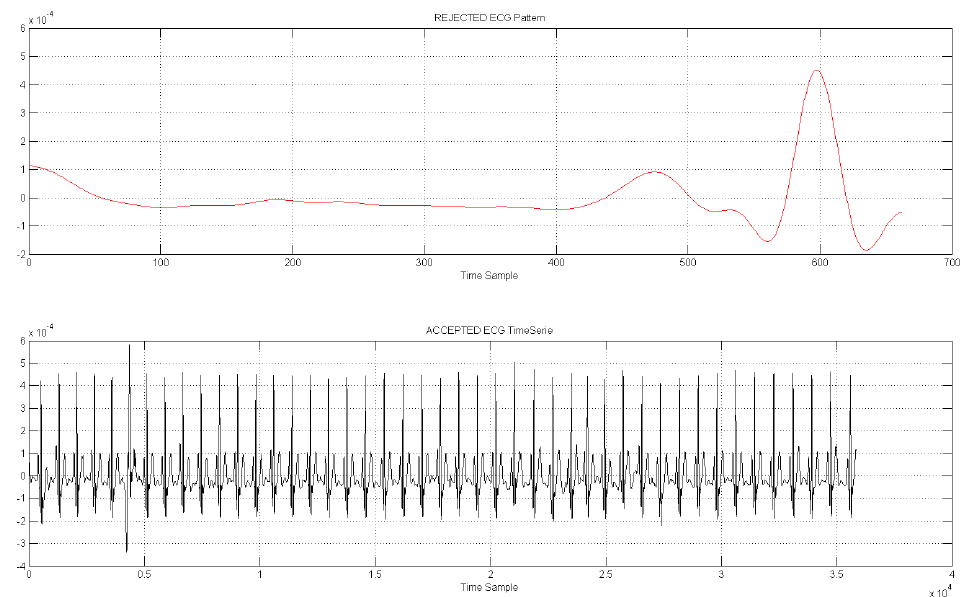
Figure 19. The accepted ECG time-serie (black signal in second window). The first window shows a sample of ECG pattern discarded by the proposed pattern recognition